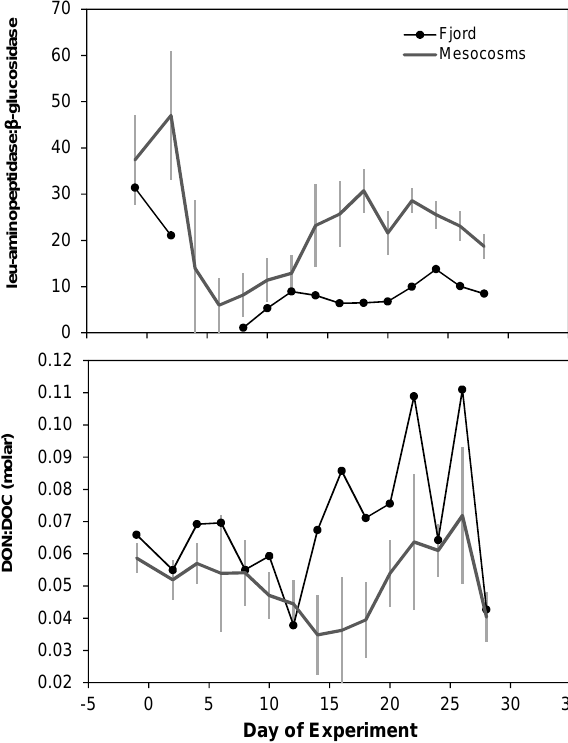
Fig. 7. Activity ratios of leucine (leu)-aminopeptidase: β - glucosidase (upper panel) and molar ratios of DON:DOC (lower panel) in mesocosms (grey line) and Kongsfjorden (black circles). Mean values ( ± SD) of all mesocosms are